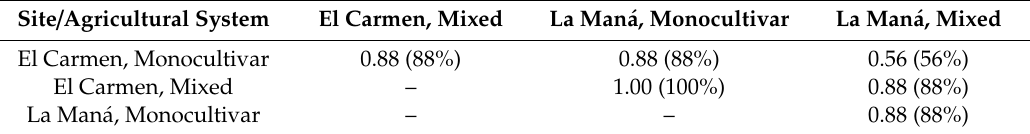
Table 8. Jaccard index of similarity (%) based on di ff erent arthropod orders between sites and production systems in